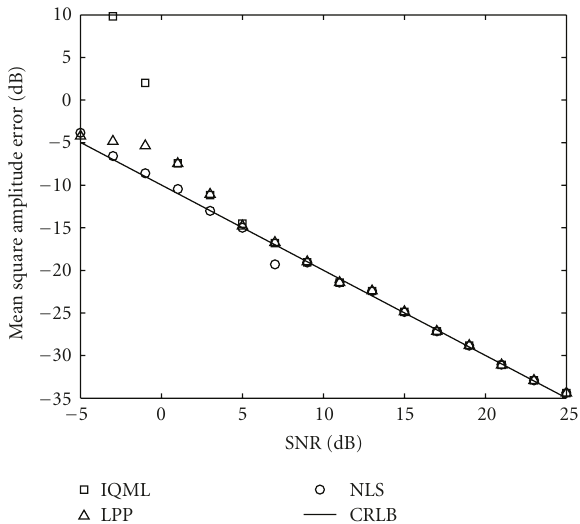
Figure 10: MSE for A of single real sinusoid with random φ .